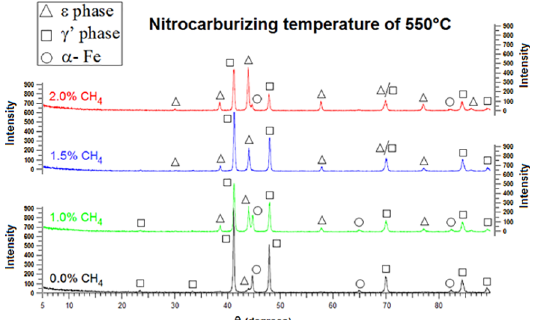
Figure 1. XRD diffractograms for samples treated at 550°C.